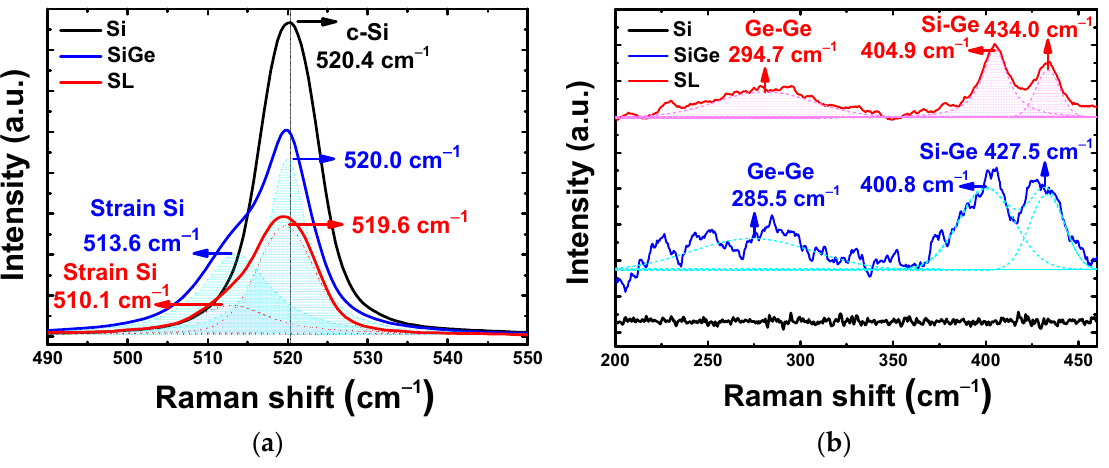
Figure 5. Raman spectra of Si, Si 0.8 Ge 0.2 , and Si 0.8 Ge 0.2 /Si SL samples of ( a ) the Si substrate and strain Si components and ( b ) Si-Ge and Ge-Ge vibration mode.